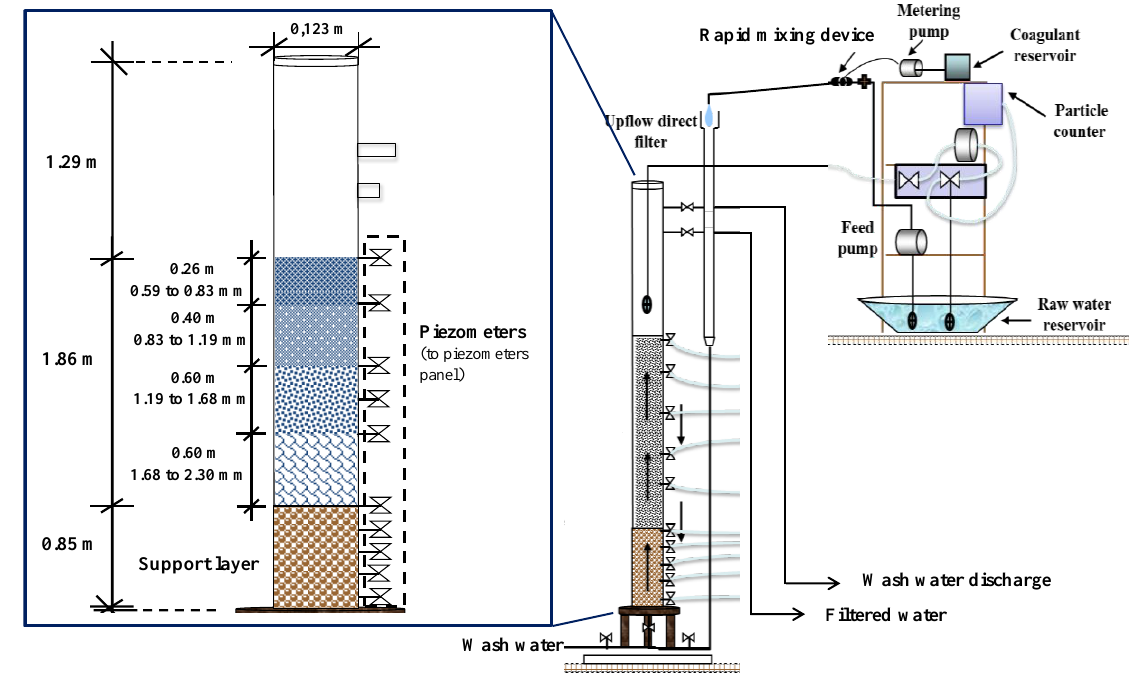
Figure 1. Schematics of pilot-scale upflow direct filtration plant (not in scale).